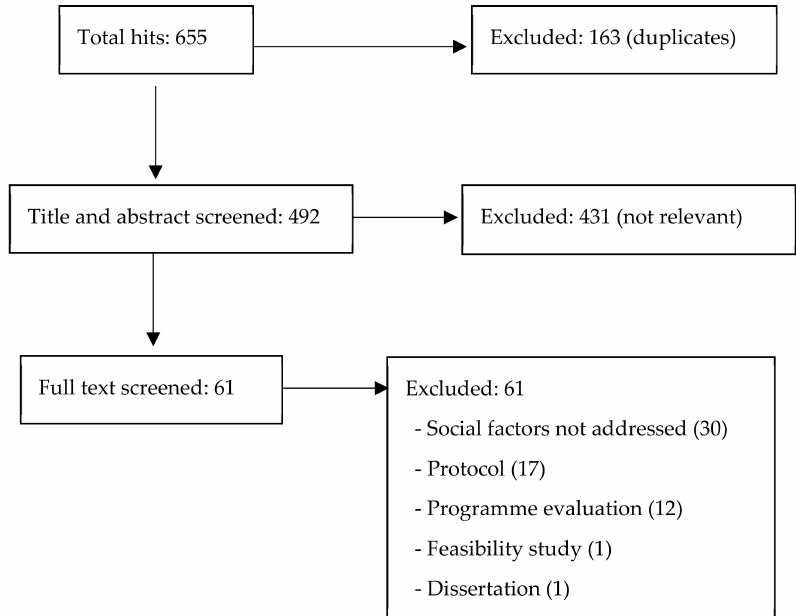
Figure 1. Literature review flow